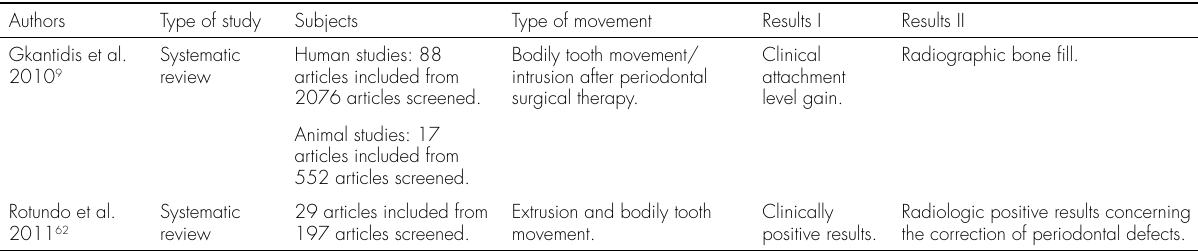
Table Ic. Orthodontic tooth movement in relation to angular bony defects treated with non-regenerative periodontal therapy: Systematic review studies subgroup. Results I: The effects on clinical periodontal parameters. Results II: The effects on angular bony defect fill and connective tissue attachment